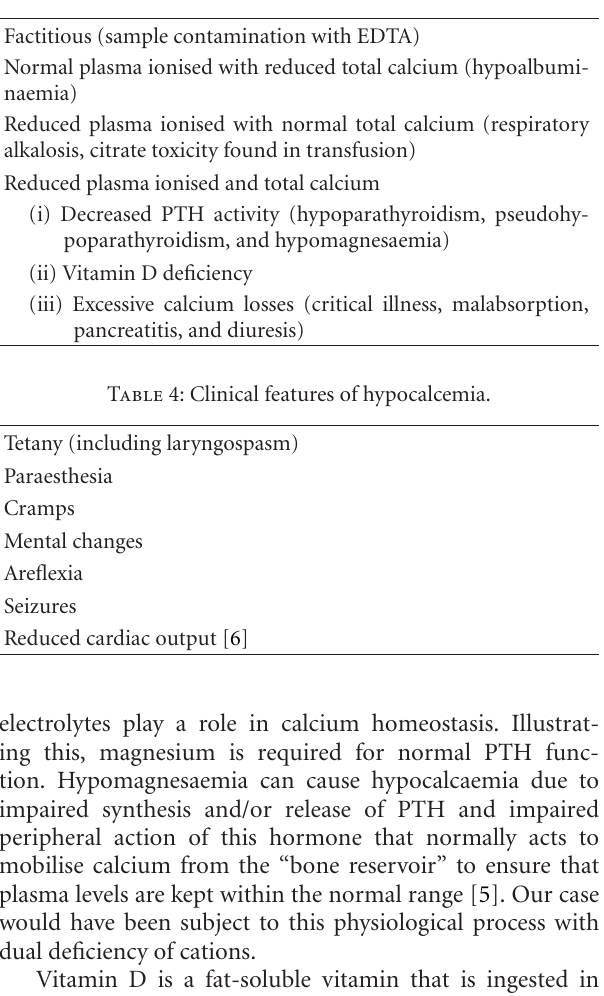
Table 3: Causes of hypocalcemia.